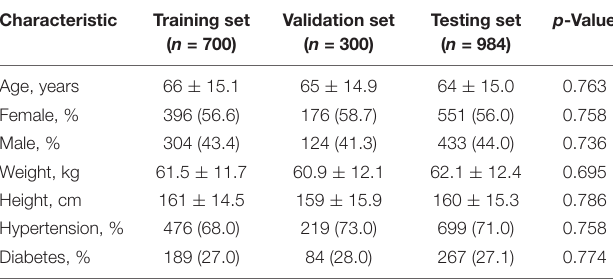
TABLE 1 | Baseline characteristics of the total study